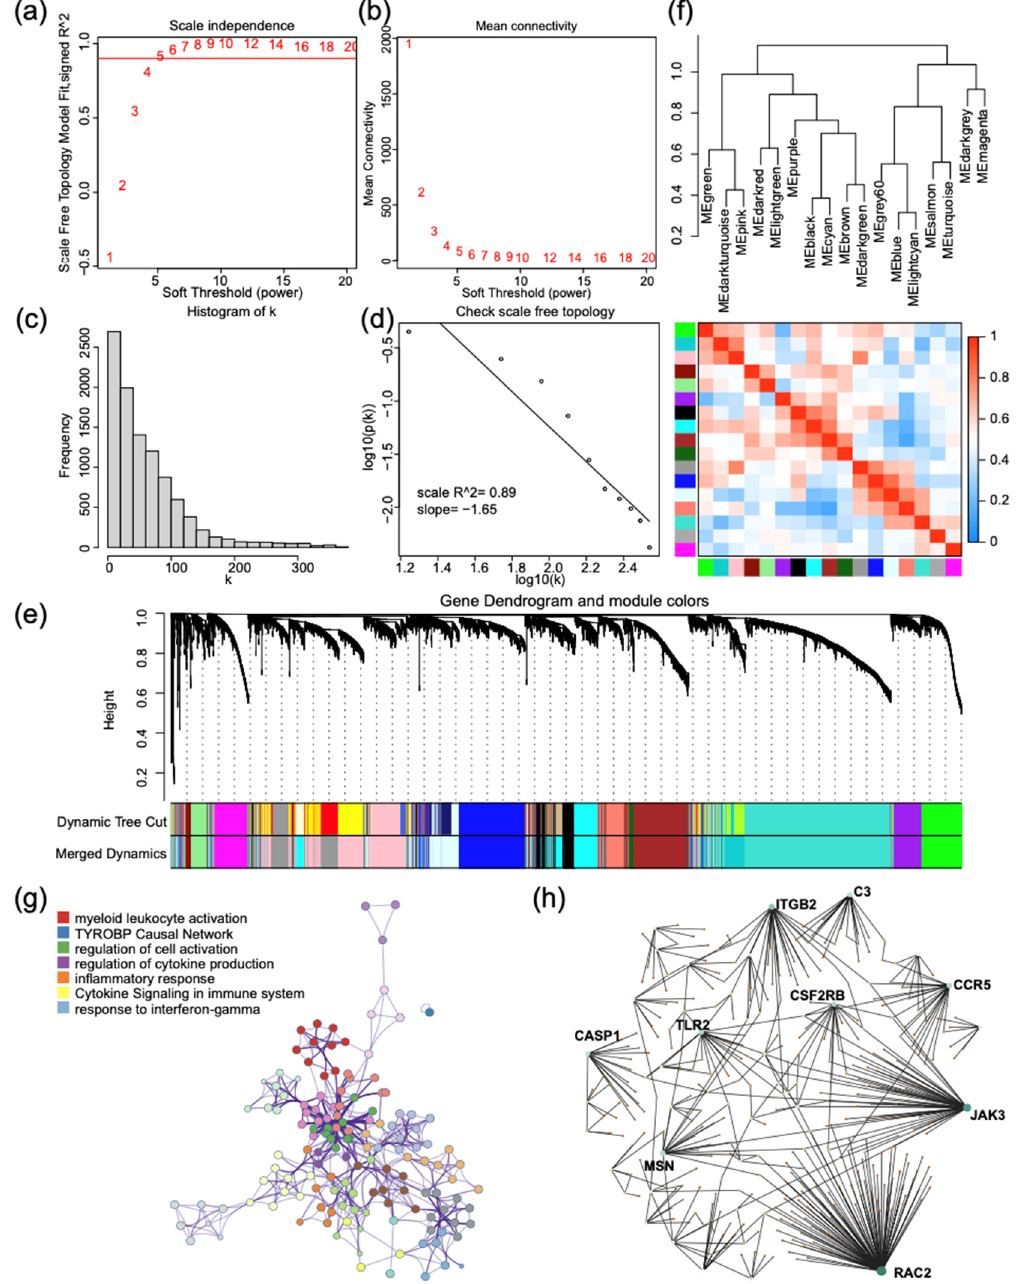
Figure 6. Construction of weighted risk stratification gene co-expression network and functional enrichment analysis. ( a , b ) The scale-free fit index for soft thresholding powers. ( c , d ) Selecting the soft threshold of 5, checking the node connection number, and verifying the network connectivity of a scale-free network. ( e ) Combining the modules with small dissimilarity, 17 weighted gene co-expression sub-networks were obtained by a dynamic tree cut algorithm. ( f ) The correlation between network modules. ( g ) Gene ontology analysis of all module genes within five members colored by specific cluster ID. ( h ) PPI network was constructed by screening the hub genes according to the fold change of DEGs in brown mod.